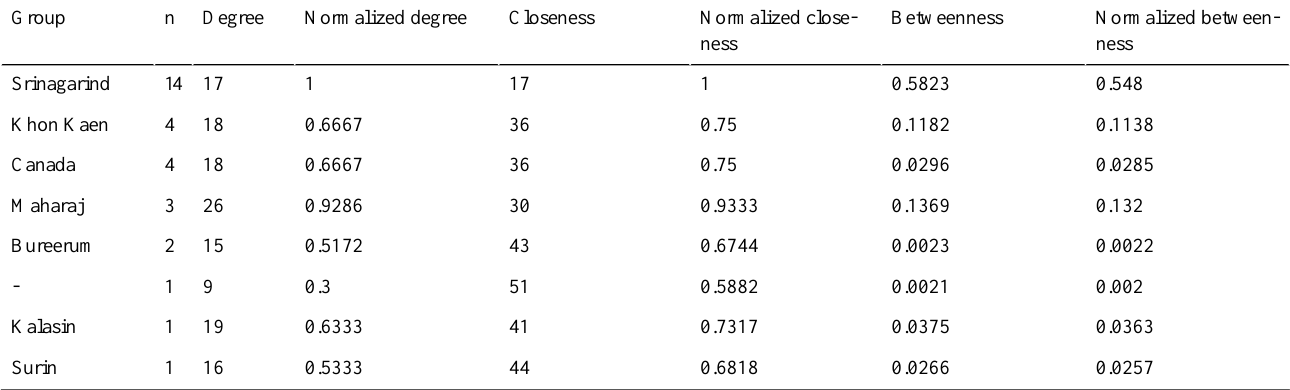
Table 8. Hospital centrality